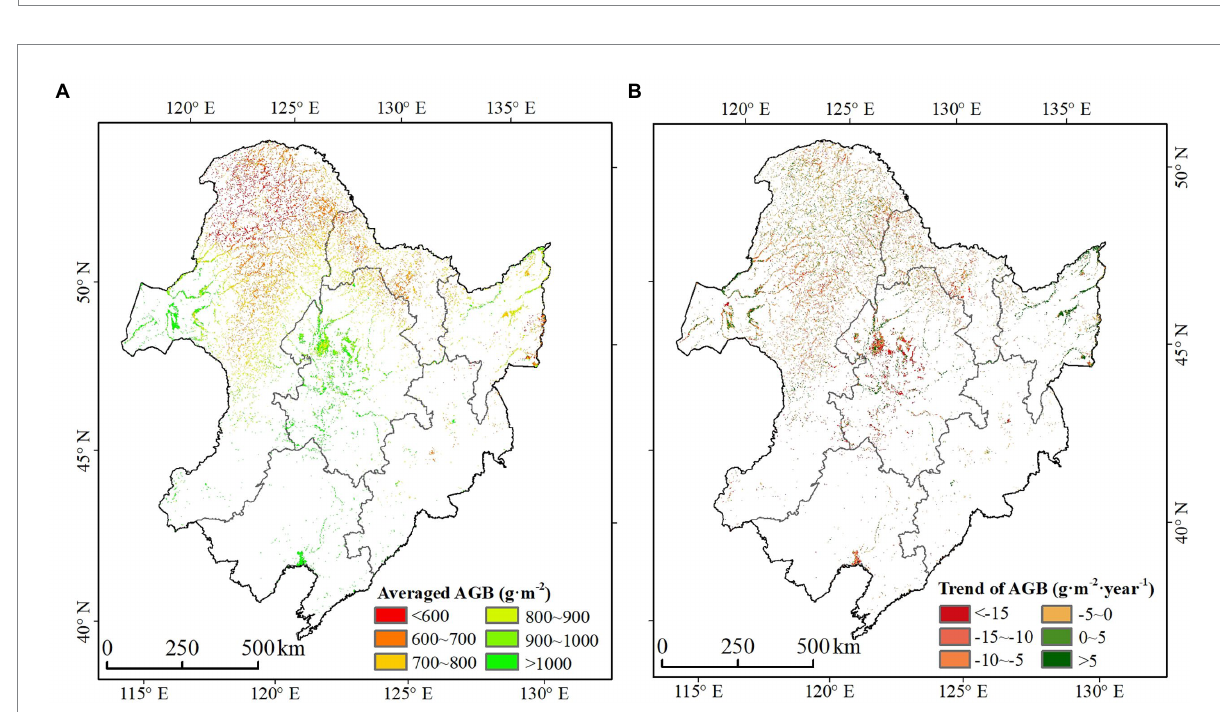
FIGURE 4 (A) Spatial patterns of averaged marsh AGB (g·m − 2 ) and (B) variation trend of marsh AGB (g·m − 2 ·year − 1 ) from 2000 to